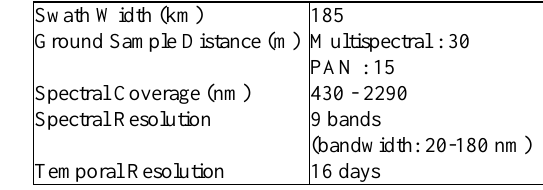
Table 2. Data specifications of the Landsat-9 Operational Land